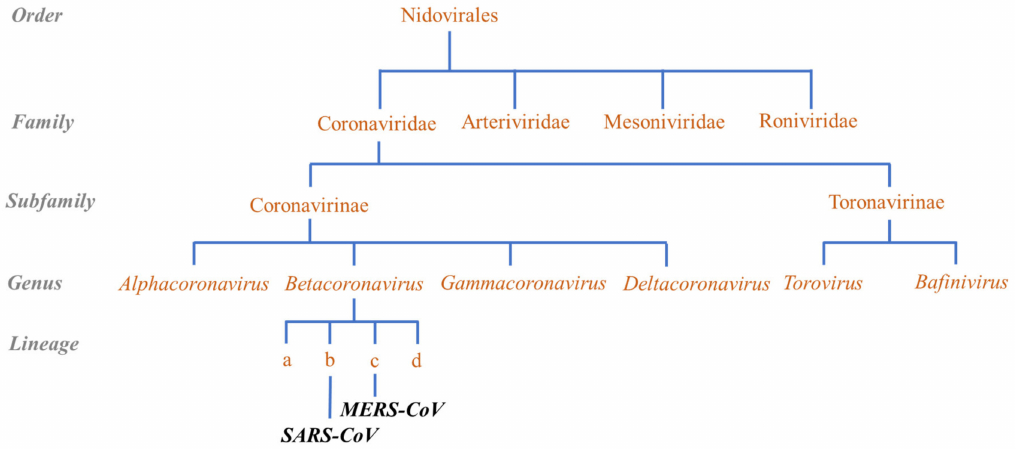
Figure 3. Classification scheme of